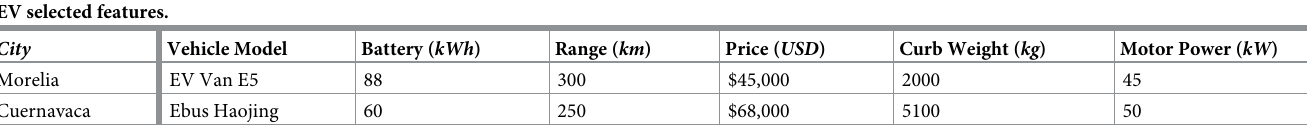
Table 6. Main characteristics of the selected electric vehicles. EV selected